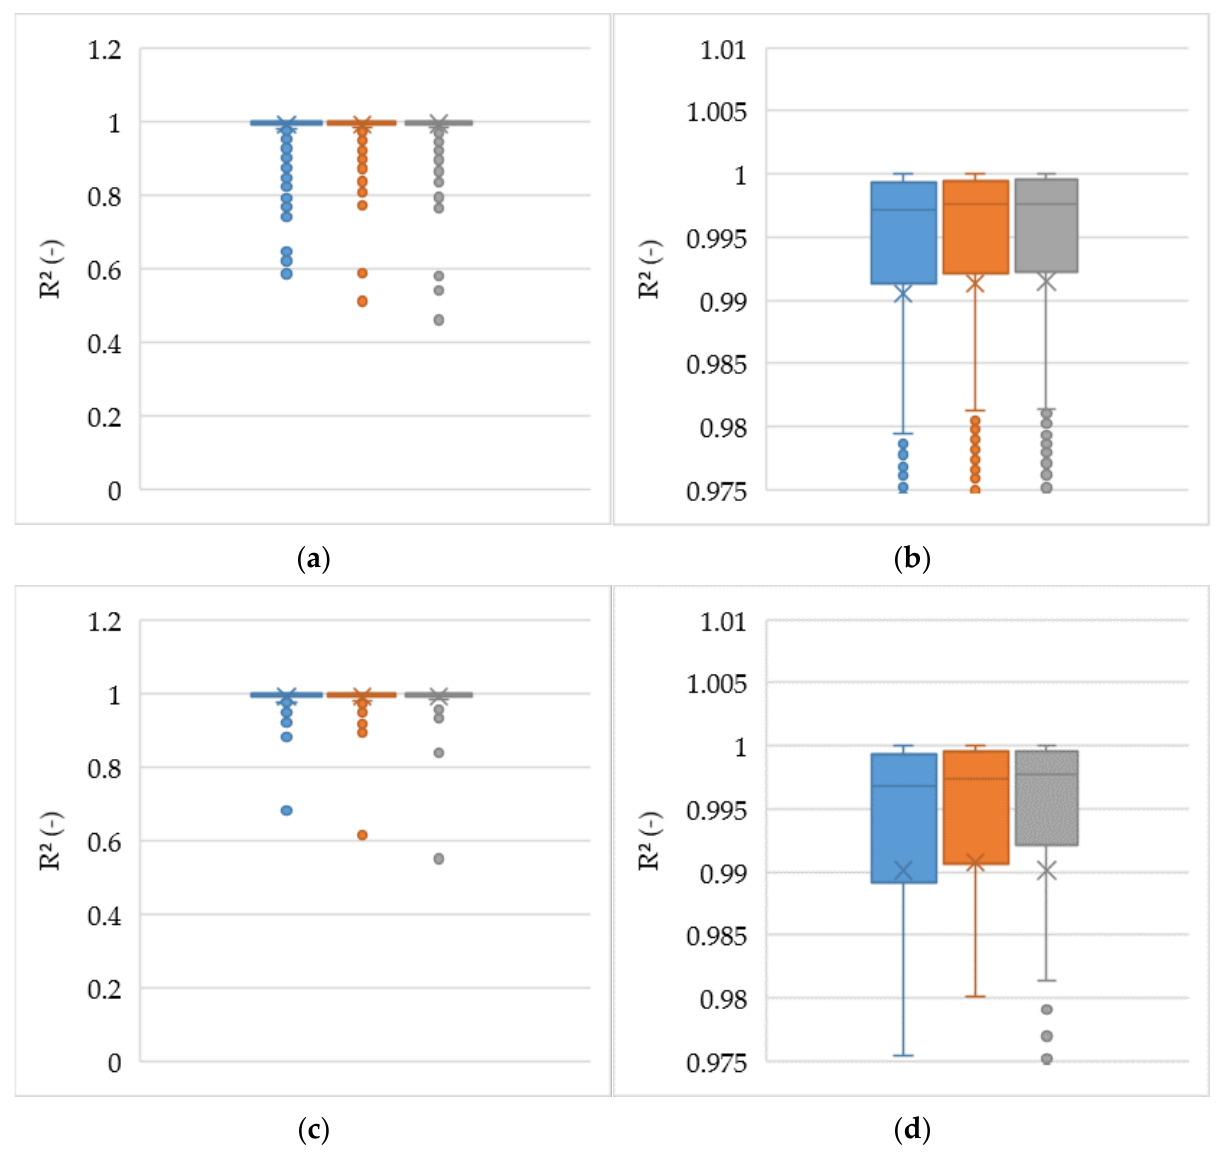
Figure 6. Box plots of the R 2 of chromatograms with the predicted parameters over the chromatograms with the original parameters. Blue box plots represent 10 CV salt gradient, orange represent 5 CV salt gradient chromatograms, and 3 CV salt gradient chromatograms are represented as grey box plots: ( a ) shows the training set data at full scale. ( b ) Shows the training set data R 2 in a high zoom state; ( c ) shows the validation data R 2 in full range, while ( d ) shows the validation data R 2 in high zoom.